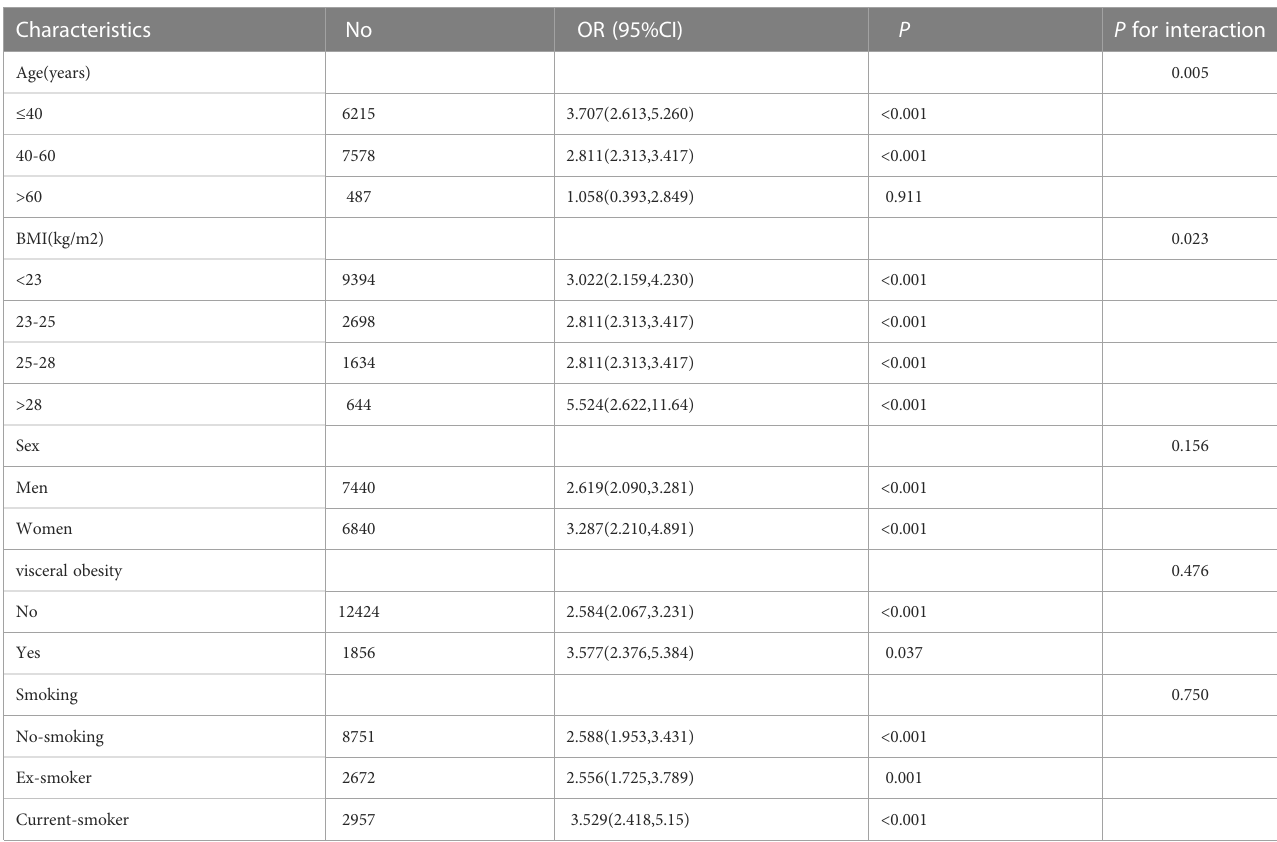
TABLE 4 Subgroup analysis and interaction of the association of HGI with